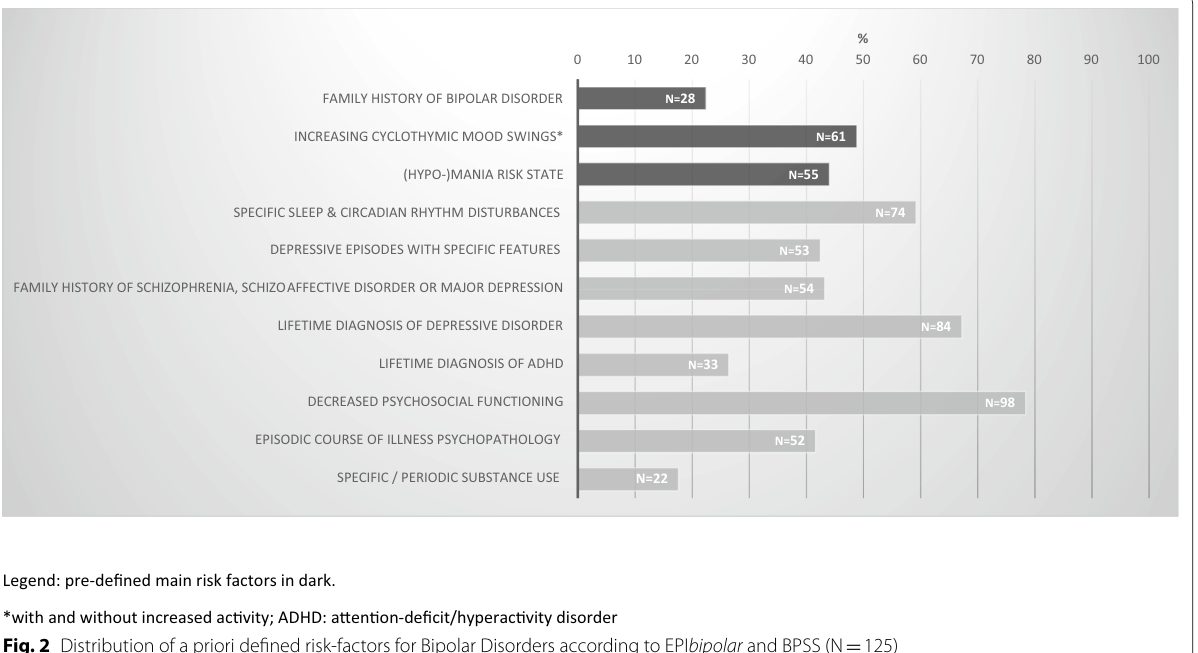
Fig. 2 Distribution of a priori defined risk‑factors for Bipolar Disorders according to EPI bipolar and BPSS (N